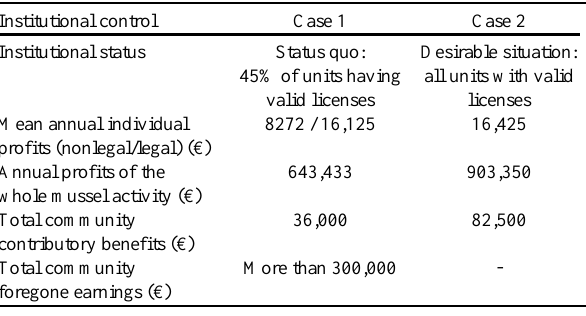
Table 8 . Economic implications of institutional